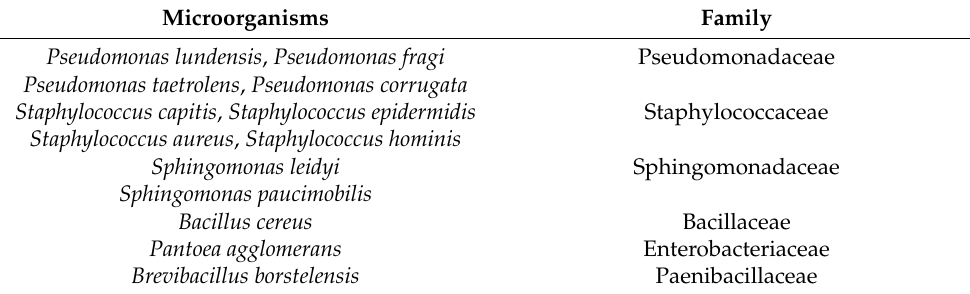
Table 6. Families of isolated